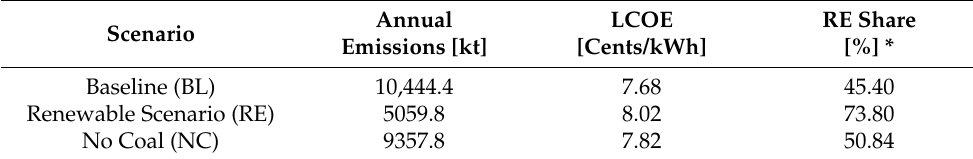
Table 7. Summary of analysis of scenarios on the supply side in 2035.